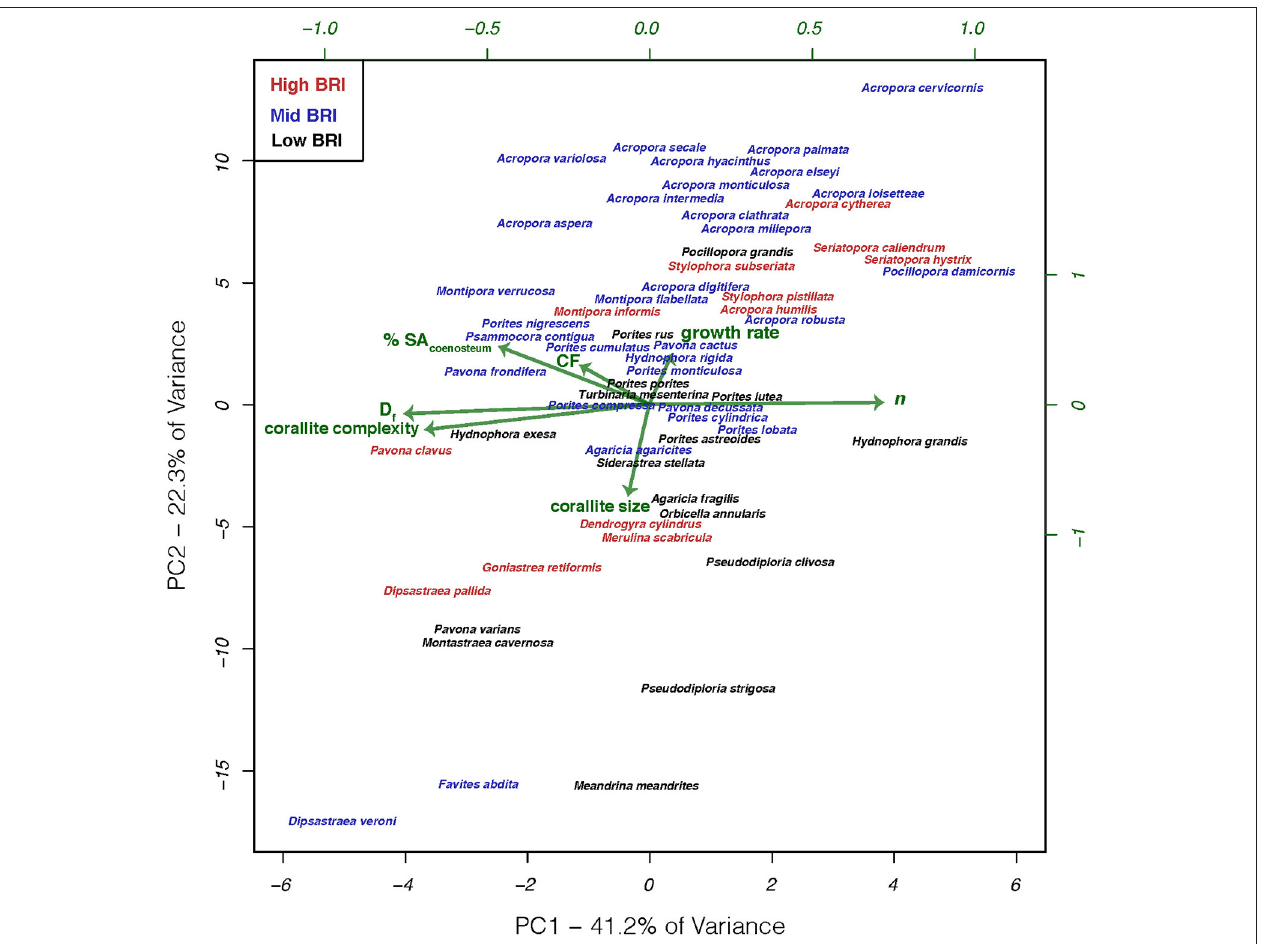
FIGURE 5 | Phylogenetic principal components analysis of characters thought to affect light microenvironments of in hospite Symbiodinium for 59 coral species. Phylogenetic correction based on the phylogeny modified from Huang (2012). Coral species color coded by bleaching response and arrows represent the relative contribution to each principal